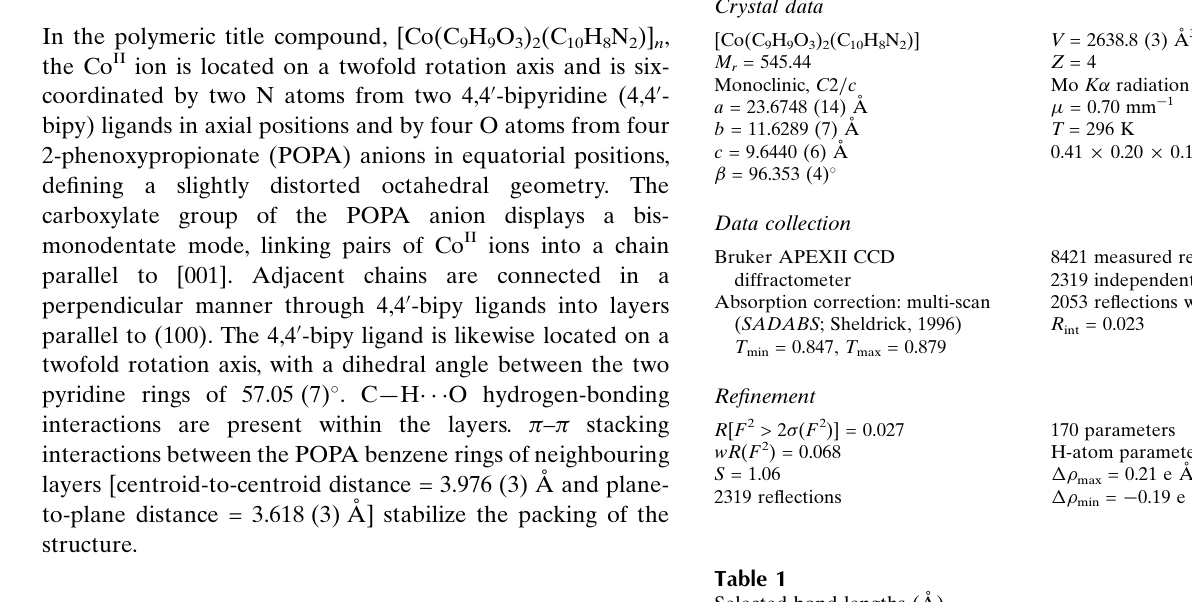
Selected bond lengths (A ˚ ).